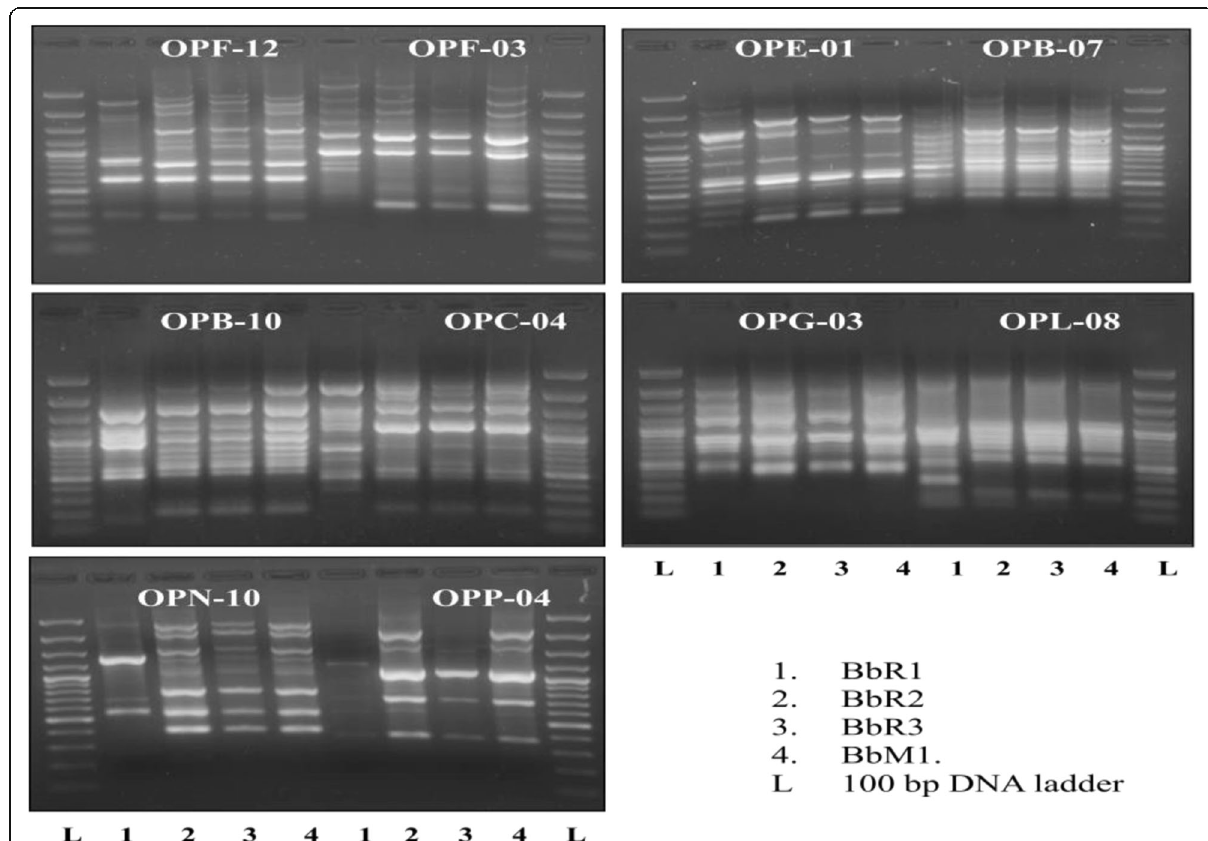
Fig. 3 Comparative RAPD-PCR amplification profile (banding pattern) of different Beauveria bassiana isolates with ten different RAPD primers